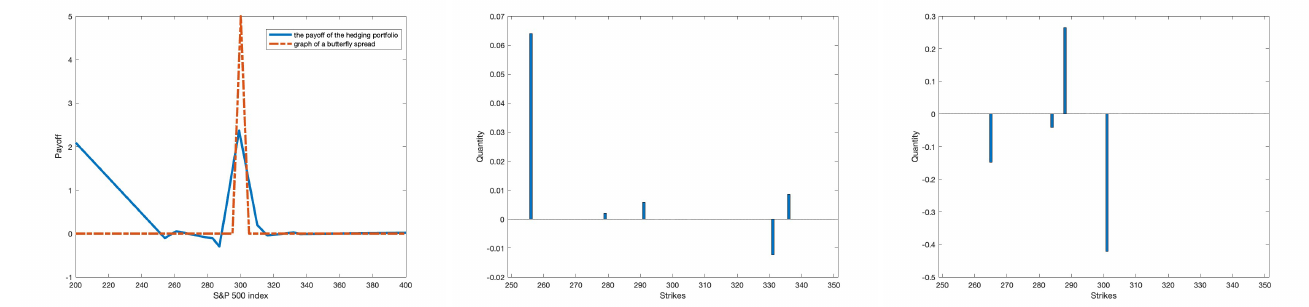
Figure 12. The payoff of the hedging portfolio with the payoff of the claim being priced of a butterfly spread option ( left ), the hedging portfolios for the put option ( center ) and call option ( right ).